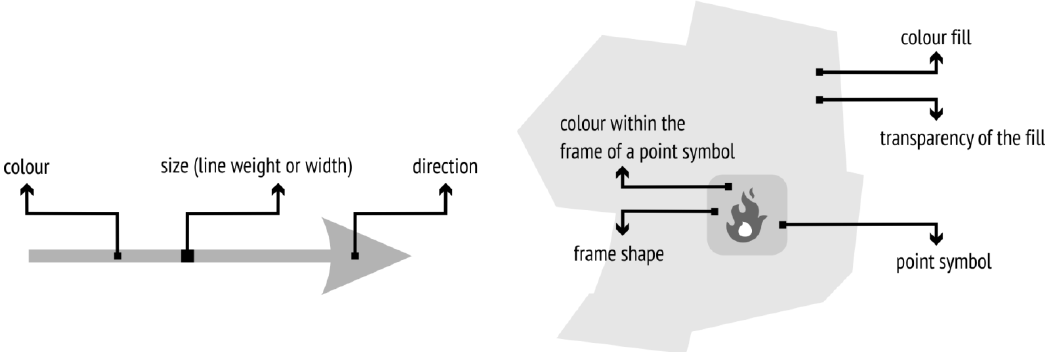
Figure 10. Integral geometric and graphic variables for depicting line and area symbols on crisis maps.